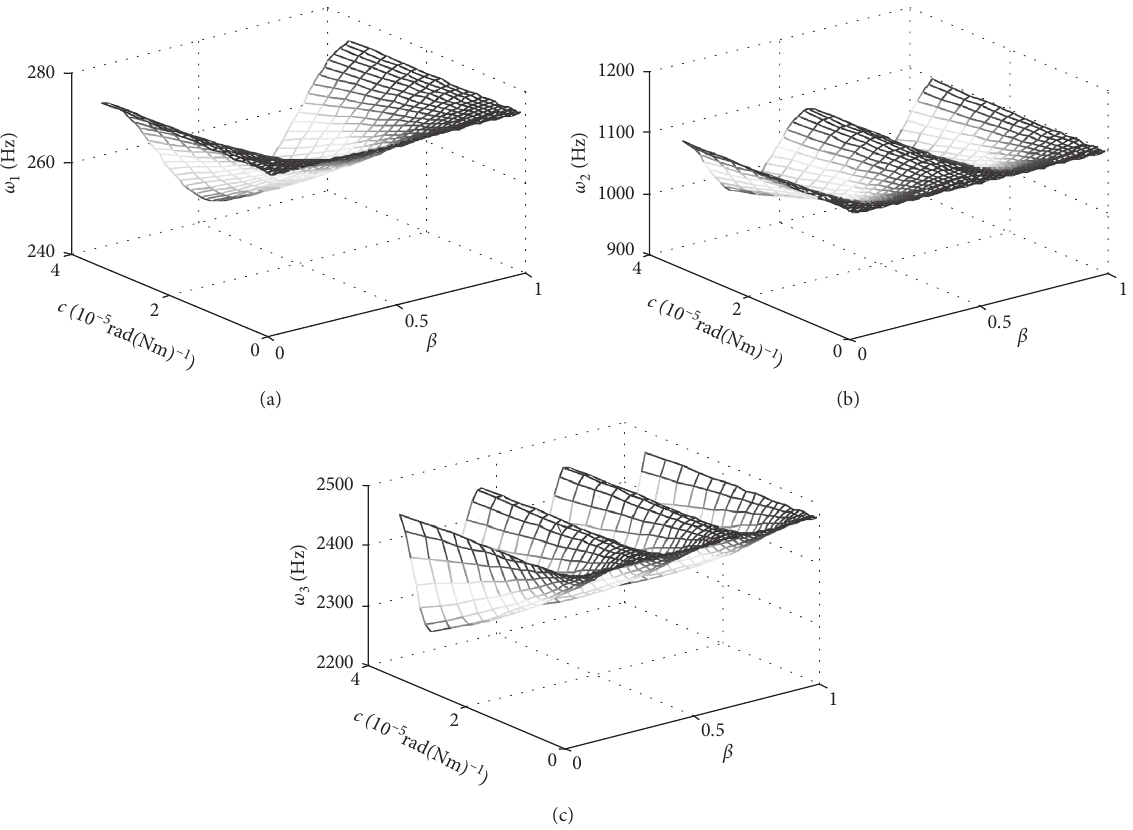
Figure 5: The first three order natural frequency influence surface. (a) The first order natural frequency affects the surface. (b) The second order natural frequency affects the surface. (c) The third order natural frequency affects the